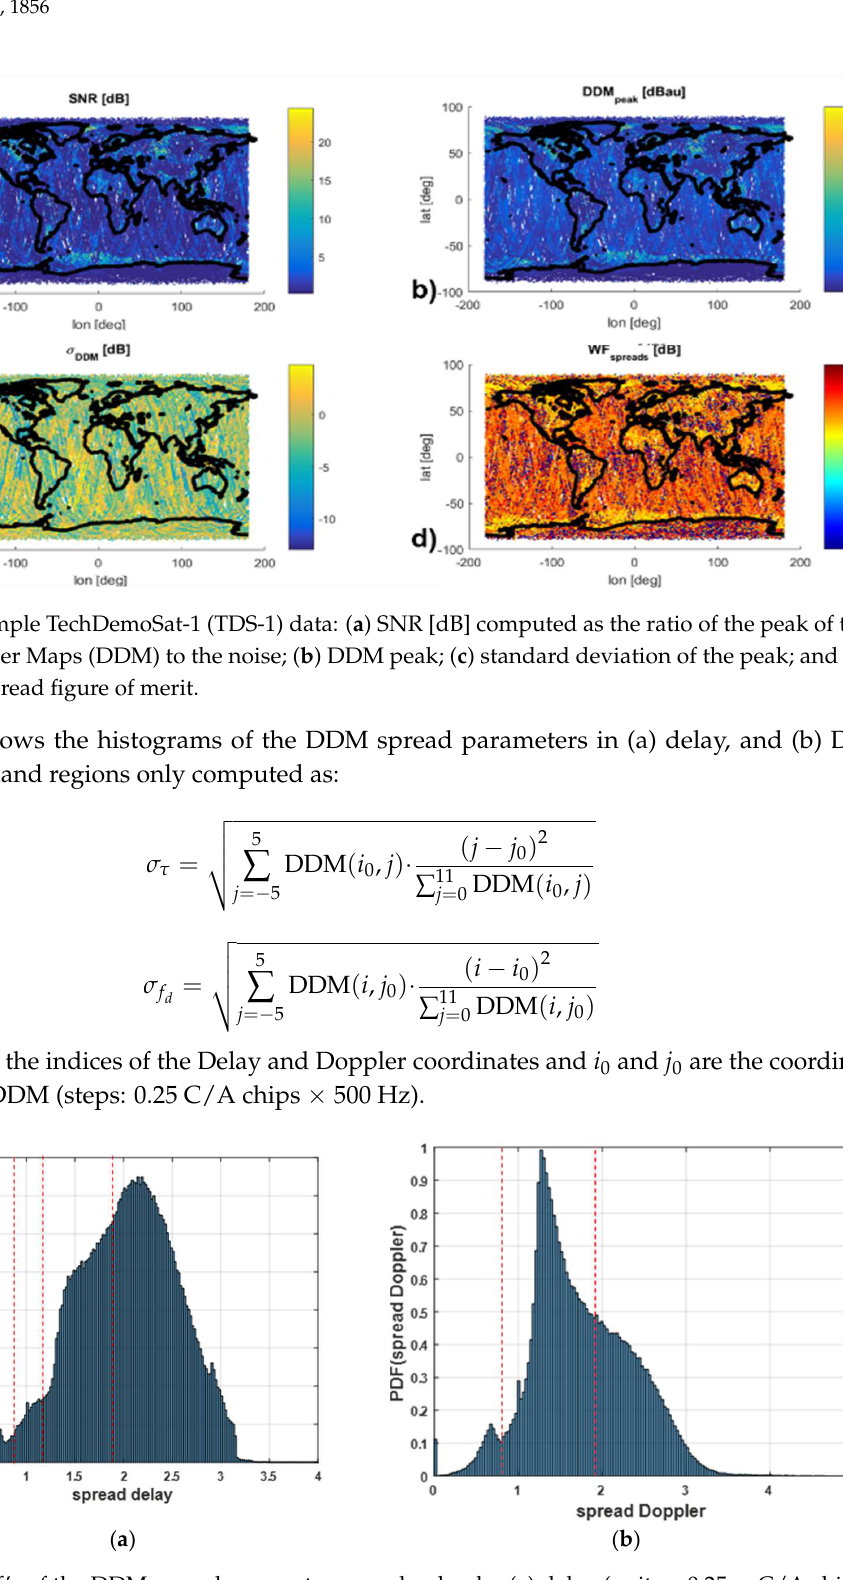
Figure 2. pdf’s of the DDM spread parameters over land only: ( a ) delay (units = 0.25 × C/A chips) and ( b ) Doppler frequency (units = 500 Hz